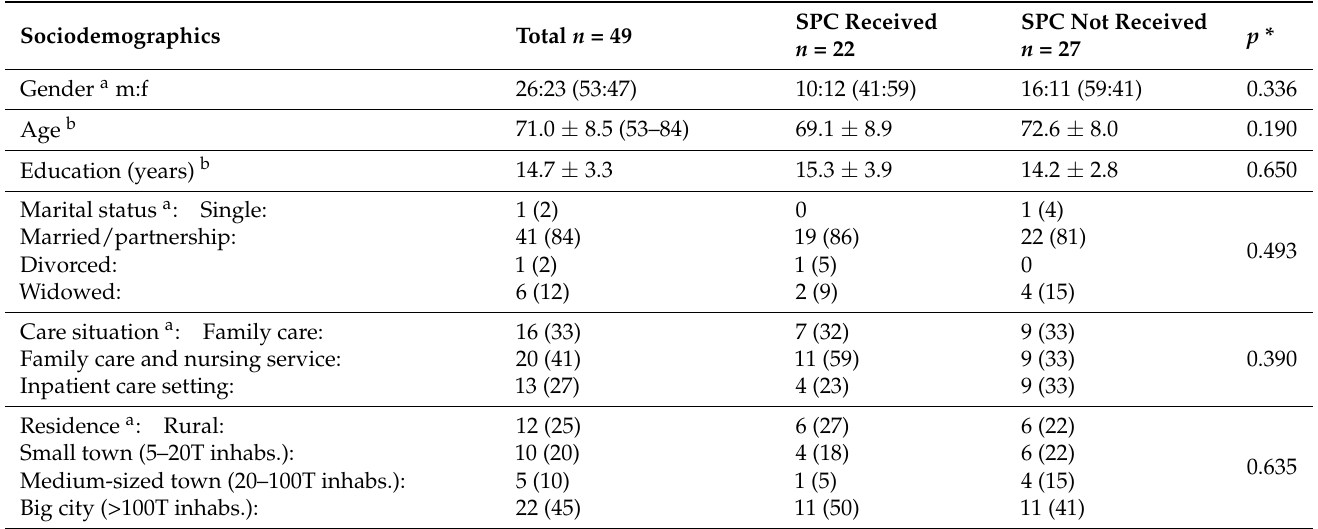
Table 2. Patient characteristics before decease ( n =